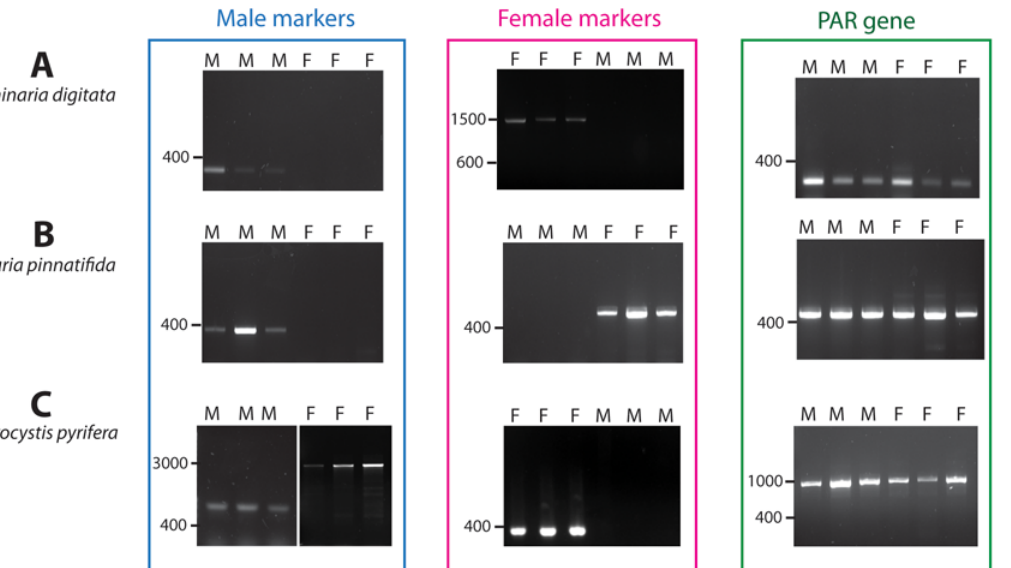
Fig 2. Electrophoresis pattern of products amplified in male and female gametophytes of three kelp species. (A) L . digitata . Male marker: M_68_16_1; Female marker: M_68_58_3; PAR gene amplification M_248_8_1 (B) U . pinnatifida . Male marker: M_68_16_2; Female marker: M_285_20_2; PAR gene amplification M_285_26_1 (C) M. pyrifera . Male marker: M_68_58_1; Female marker: M_68_58_2; PAR gene amplification M_357_3_1. M, male gametophyte; F, female gametophyte. Note that in M . pyrifera , M_68_58_1 amplified products of different sizes from male and female M . pyrifera